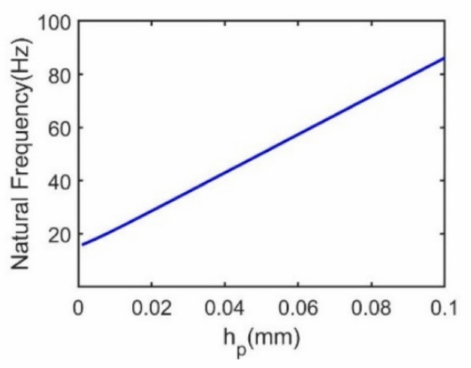
Figure 11. Relationship between natural frequency and piezoelectric layer thickness.